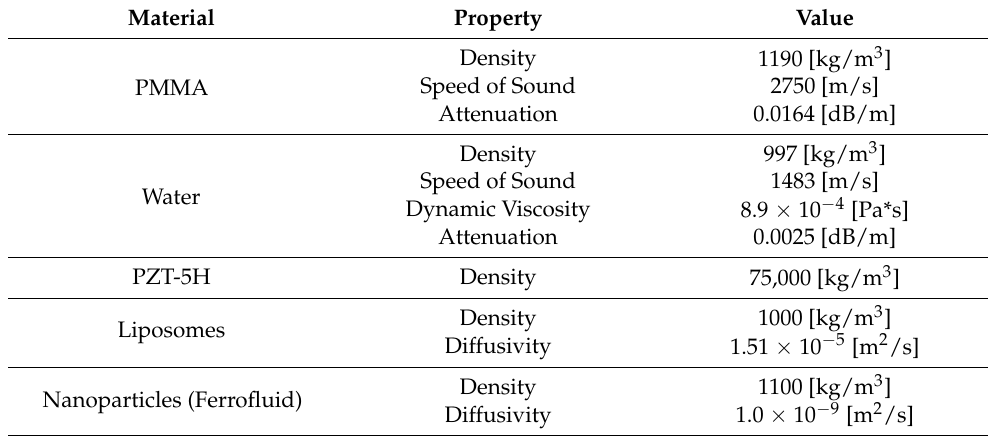
Table 1. Material properties included in the multiphysics model 1